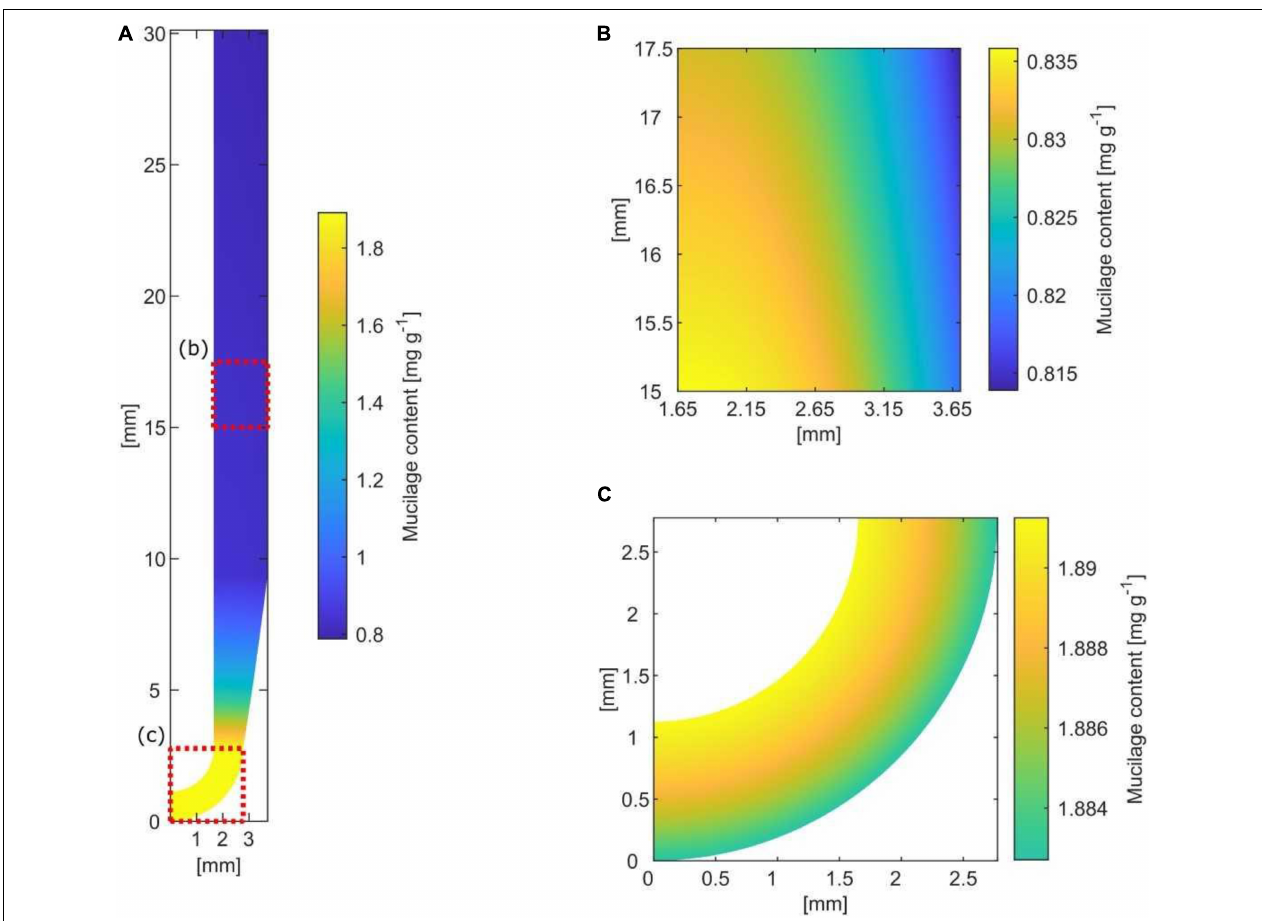
FIGURE 4 | Spatial and temporal distribution of mucilage around a root segment grown within 1 day (= 30 mm) [ (A) along the root; (B) lateral; (C) at the root tip]. Mucilage-affected soil is indicated by yellow to blue color along the root and by yellow to green at the root tip, reflecting the increasing radial extent by swelling as well as the decreasing content of mucilage by